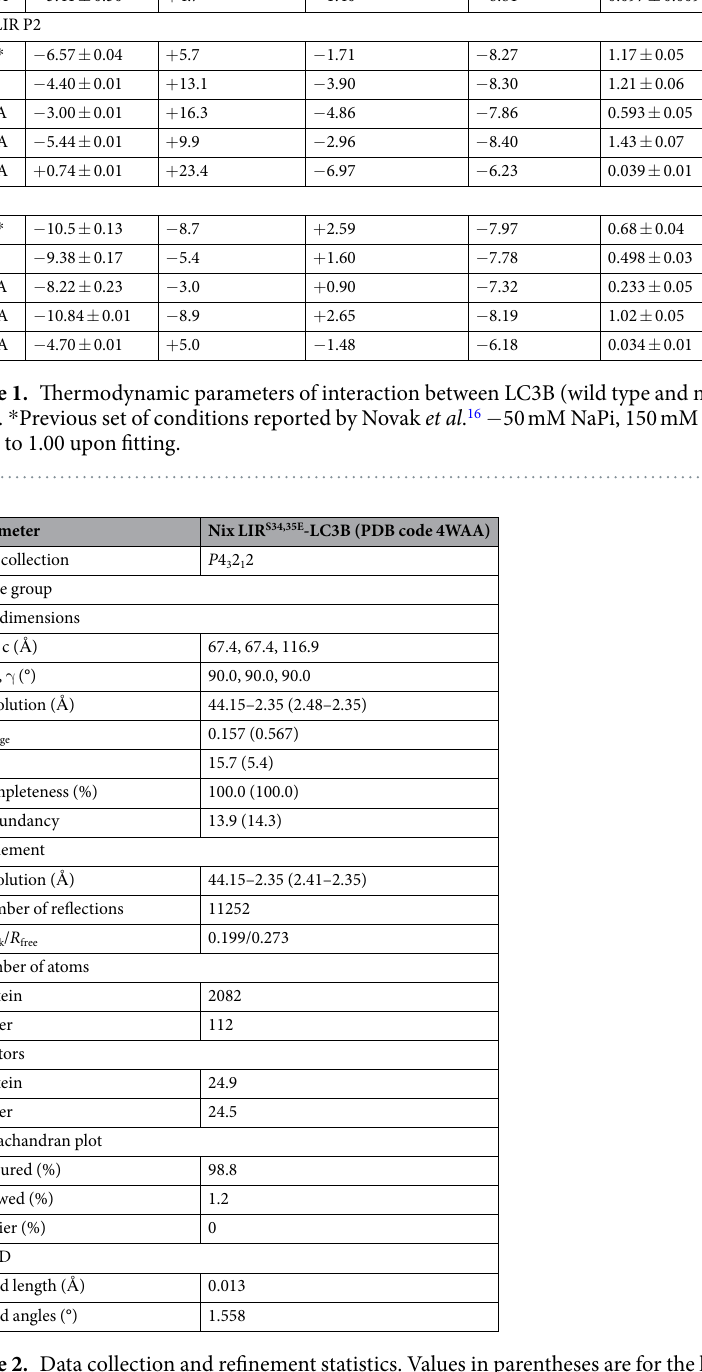
might be flexible in solution. Therefore, in the LIR bound state, the Glu34 residue very likely exists close to Arg10, Arg11 and Lys51 of LC3B and interacts with these side-chains. It was recently reported that the side-chain of Lys49 of LC3A regulates the binding of LIR peptides through a gating mechanism 12 . The structural comparison of free LC3A and its complex with the Atg13 LIR motif demon- strated that the side-chain of Lys49 undergoes a 6.7 Å movement in the LIR bound state, providing access to the